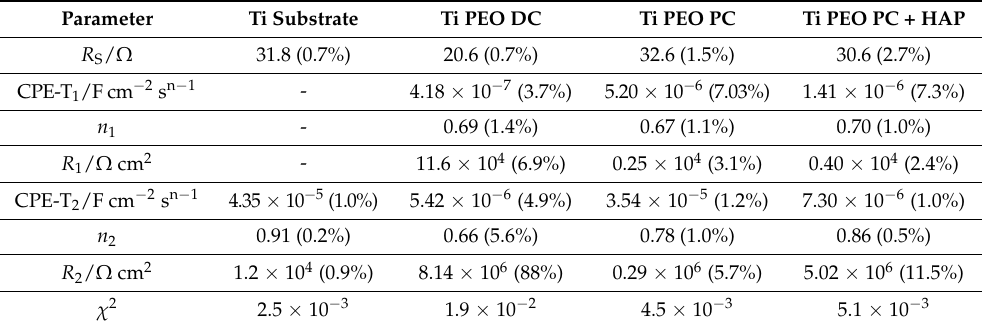
mental EIS data to the proposed electrical equivalent circuits. Table 3. EIS parameters were obtained by fitting the experimental data of untreated Ti and PEO- treated Ti